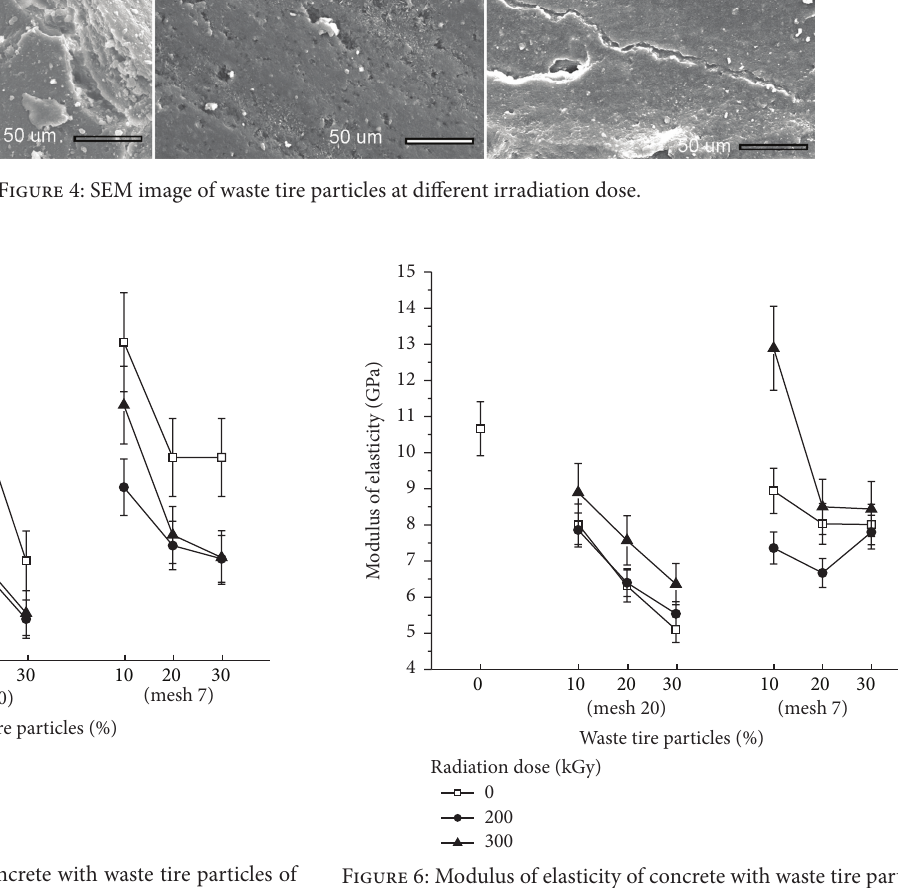
Figure 6: Modulus of elasticity of concrete with waste tire particles of 0.85 mm and 2.8 mm.